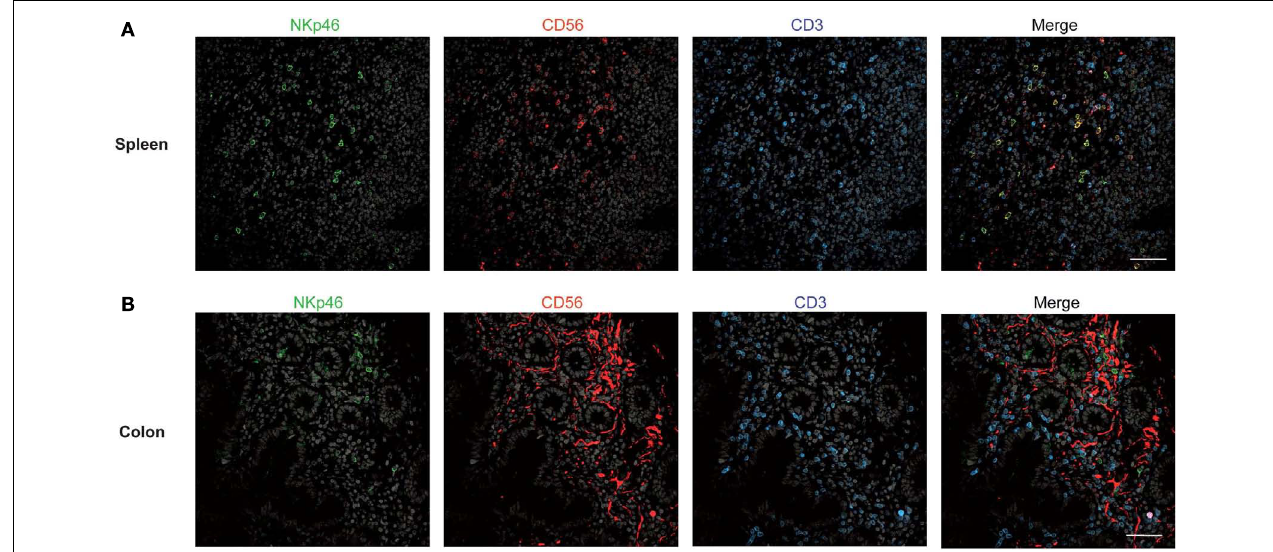
anti-CD3 mAb (blue). Nuclei were counterstained with Sytox (gray). Scale bar = 50 µ m. Data are representative of at least two independent experiments performed on three distinct individuals.